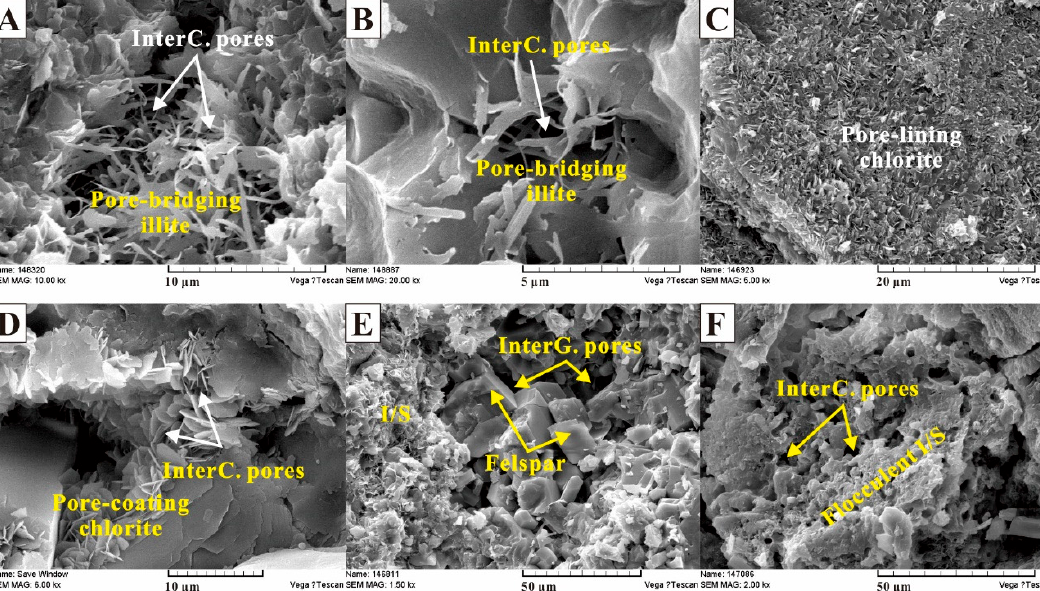
Figure 3. Morphologies of various types of clay minerals and pore types in the tight gas reservoirs of the Xujiaweizi Rift. InterC. = intercrystalline; InterG. = intergranular; I / S = mixed-layer illite / smectite. ( A ) Sample #6; ( B ) sample #6; ( C ) sample #8; ( D ) sample #8; ( E ) sample #1; ( F ) sample #2.